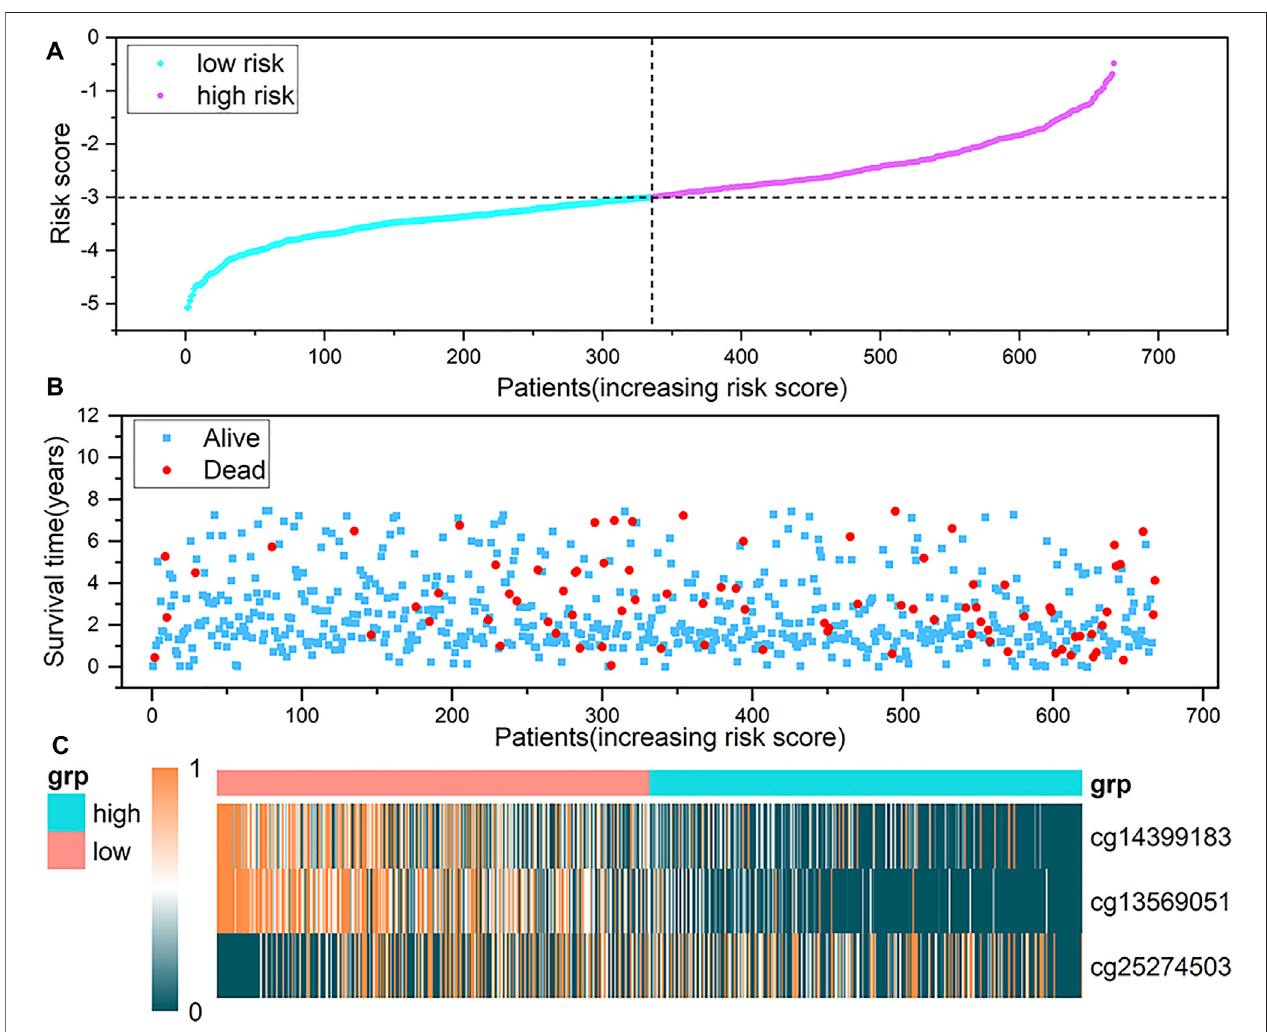
FIGURE 7 | Analysis of risk scoring model. (A) represents the characteristic risk score distribution of the three methylation probes. (B) is a scatter plot of the patient ’ s survival time. (C) is the heat map of DNA methylation level, and a row represents a CpG probe, acolumn represents apatient. The three graphs have the same abscissa, and the abscissa is the patient in ascending order of risk score.